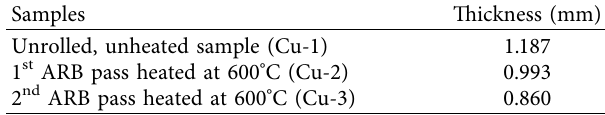
Table 2: ARB experimental results of experiment 1.